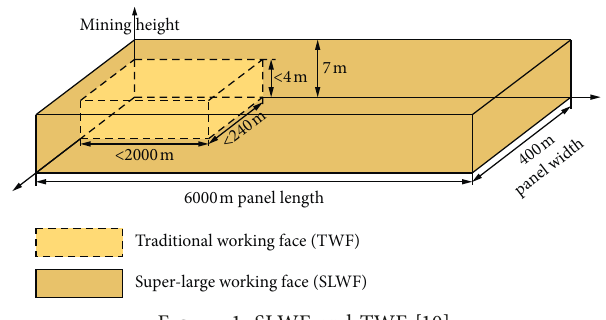
Figure 1: SLWF and TWF